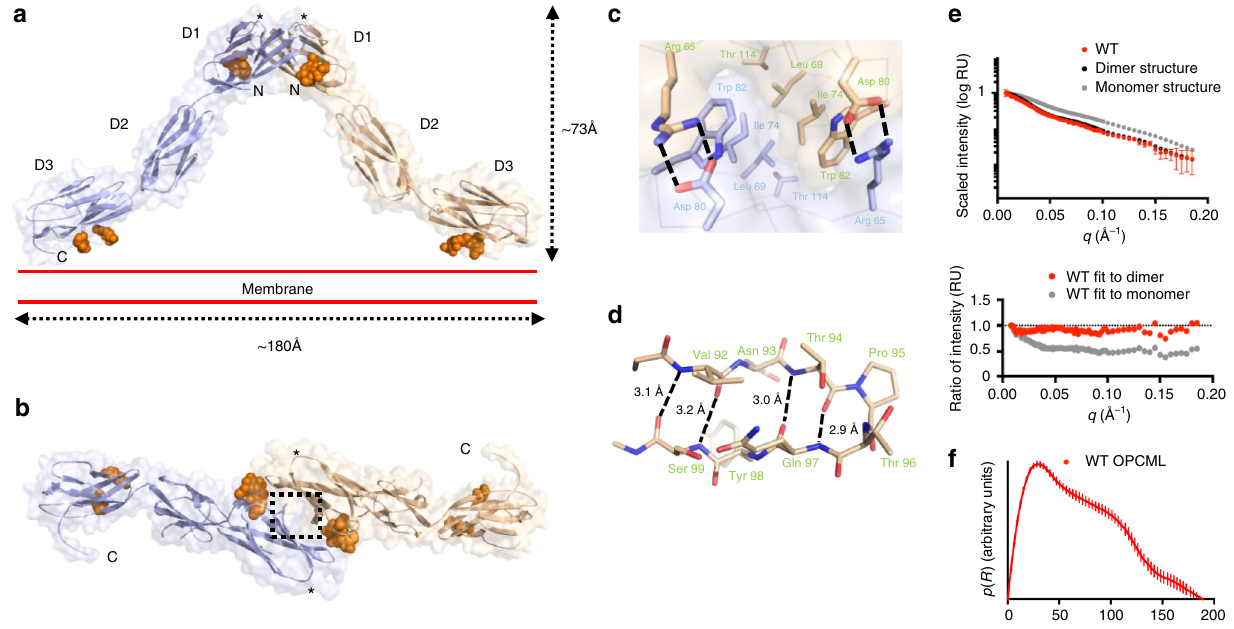
Fig. 1 Crystal structure of the OPCML homodimer. a Ribbon representation overlaid on a transparent surface illustrating the dimeric architecture of OPCML. One monomer is colored blue and the other wheat. N-linked glycosylation (on asparagines 70, 293, and 306) are shown as orange spheres. Location of P95 indicated by asterisk. N- and C- termini are indicated. Red parallel lines show the relative orientation of OPCML to the plasma membrane (on the extracellular side). Scale bars are shown to illustrate maximum dimensions. b Represented the same as in a but viewed from the top. The dashed rectangle represents key residues at the dimerization interface and these are shown in detail in c . c The D1-D1 homodimerization interface. Arg 65 from one monomer forms a salt bridge with Asp of the other monomer. Below Arg 65 is a stacking interaction involving Trp 82, Ile 74, Leu 69, and Thr 114. Same color scheme as in a , b . The alpha carbon backbone is shown as thin lines. d Stick representation of the β -turn encompassing residue P95, shown in wheat. Residues 92 – 94 and 97 – 99 form part of the D and E β – strands, respectively. Hydrogen bonds are indicated by dashed lines. e Small angle X-ray scattering analysis of WT OPCML. Scattering curves were measured and compared to calculated data of the dimer as seen in the crystal structure and of a monomeric model of OPCML. The fi t to the dimer ( χ = 0.50) matches more closely than to the monomer ( χ = 2.35). f Pair-distance distribution function curve for WT OPCML. The curve intercepts the x -axis at R = 189 A ̊ , indicating the maximum atomic distance in a single scattering particle. This model- independent parameter is consistent with the maximum manually measured dimension of the dimer structure (~180 A ̊ ), and is signi fi cantly larger than the maximum dimension of the monomer structure (~124 A ̊